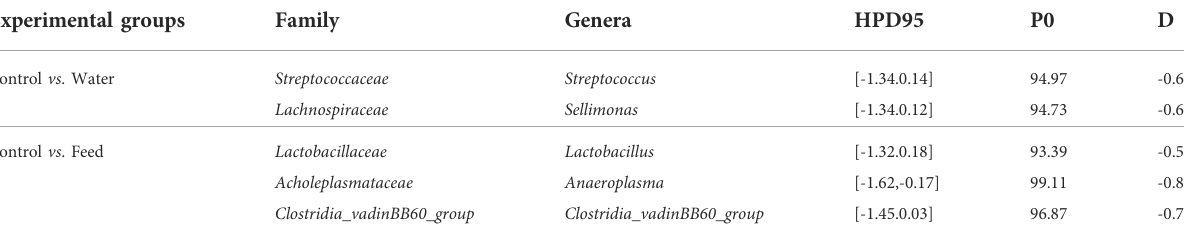
TABLE 1 Caecal microbiota features characterised for Salmonella -free broilers treated with a Salmonella phage. Key genera identi fi ed by partial least square-discriminant analysis (PLS-DA) for discriminating between groups with relevant differences in mean abundance based on Bayesian statistical analysis in water- and feed-phage treated chickens compared with the control group, computed as control vs. water and control vs. feed. The water group received a 10 8 PFU/ml phage concentration via drinking water. The feed group received a 10 8 PFU/g phage concentration via feed (encapsulated). The control group did not receive a phage.